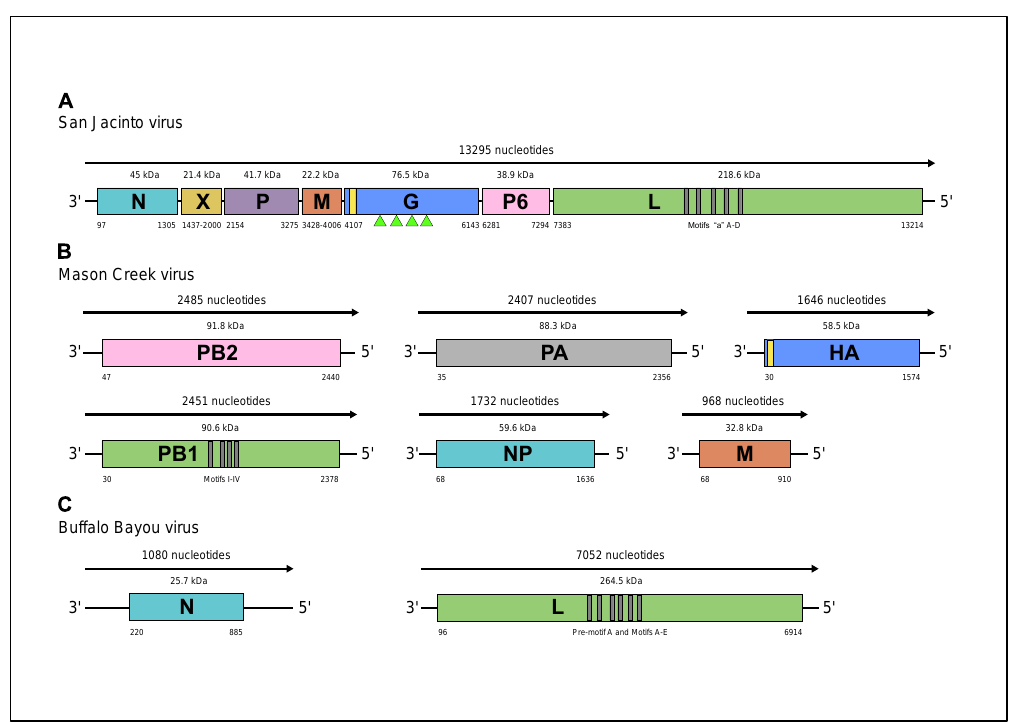
Figure 2. Schematic representation of the genome organizations ( a ) SJCV; ( b ) MCV; and ( c ) BBAV. Green triangles indicate the location of predicted glycosylation sites.